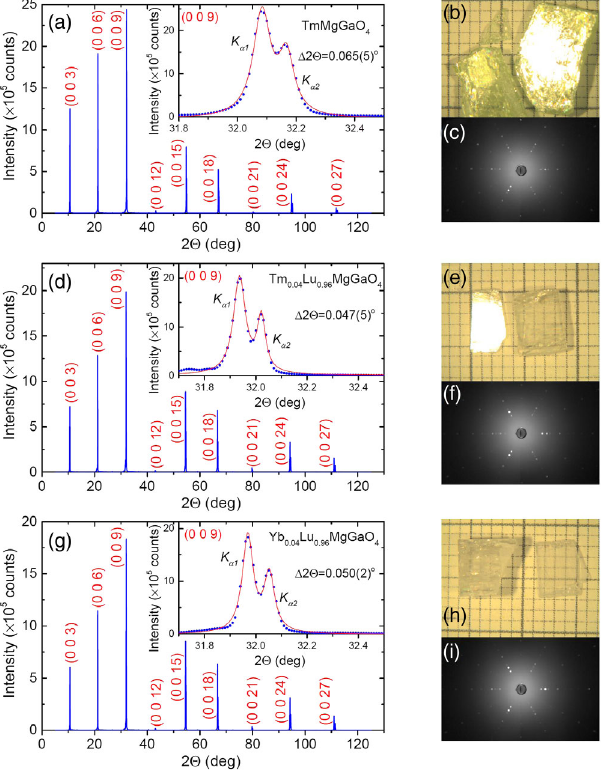
FIG. 6. (a) X-ray diffraction for the TmMgGaO 4 single crystal on the ab plane. The inset presents an enlargement of the strongest Bragg peak (009), where the angle ( 2 Θ ) difference between the nearest-neighbor data points is 0.01°. (b) Single crystals of TmMgGaO 4 cut along the ab plane. (c) Laue x-ray diffraction pattern of TmMgGaO 4 on the ab plane. (d) X-ray diffraction for the Tm 0 Lu 0 MgGaO 4 single crystal on the ab . 04 . 96 plane. The inset presents an enlarged plot of the strongest Bragg peak (009). (e) Single crystals of Tm 0 Lu 0 MgGaO 4 . 04 . 96 cut along the ab plane. (f) Laue x-ray diffraction pattern of Tm 0 Lu 0 MgGaO 4 on the ab plane. (g) X-ray diffraction for . 04 . 96 the Yb 0 Lu 0 MgGaO 4 single crystal on the ab plane. The inset . 04 . 96 presents an enlargement of the strongest Bragg peak (009). (h) Single crystals of Yb 0 Lu 0 MgGaO 4 cut along the ab . 04 . 96 plane. (i) Laue x-ray diffraction pattern of Yb 0 Lu 0 MgGaO 4 . 04 . 96 on the ab